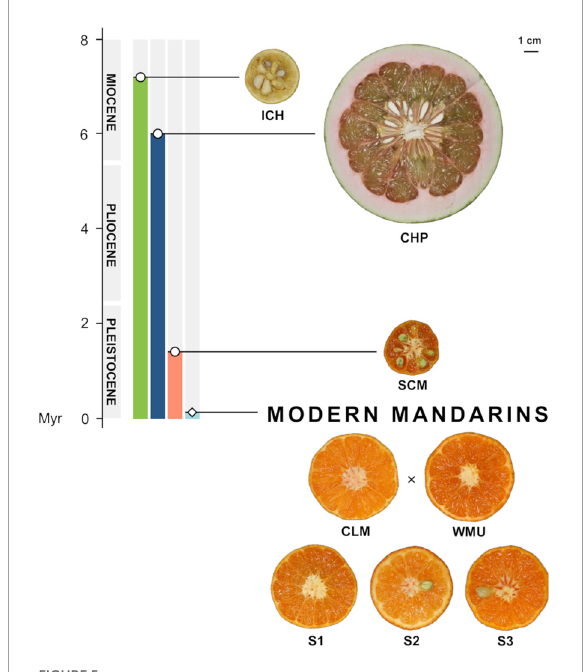
FIGURE5 Timeline showing the emergence of the citrus mentioned in this study, according to Wu et al. (2018, 2021). ICH, Ichang papeda ( C. ichangensis ); CHP, Chandler pummelo ( C. maxima ); SCM, Sun Chu Sha Kat mandarin ( C. reticulata ); CLM, Clementine mandarin ( C. clementina ); WMU, W. Murcott mandarin ( C. reticulata ), and segregants S1, S2, and S3. The hybrid origin of these three segregants is marked with a